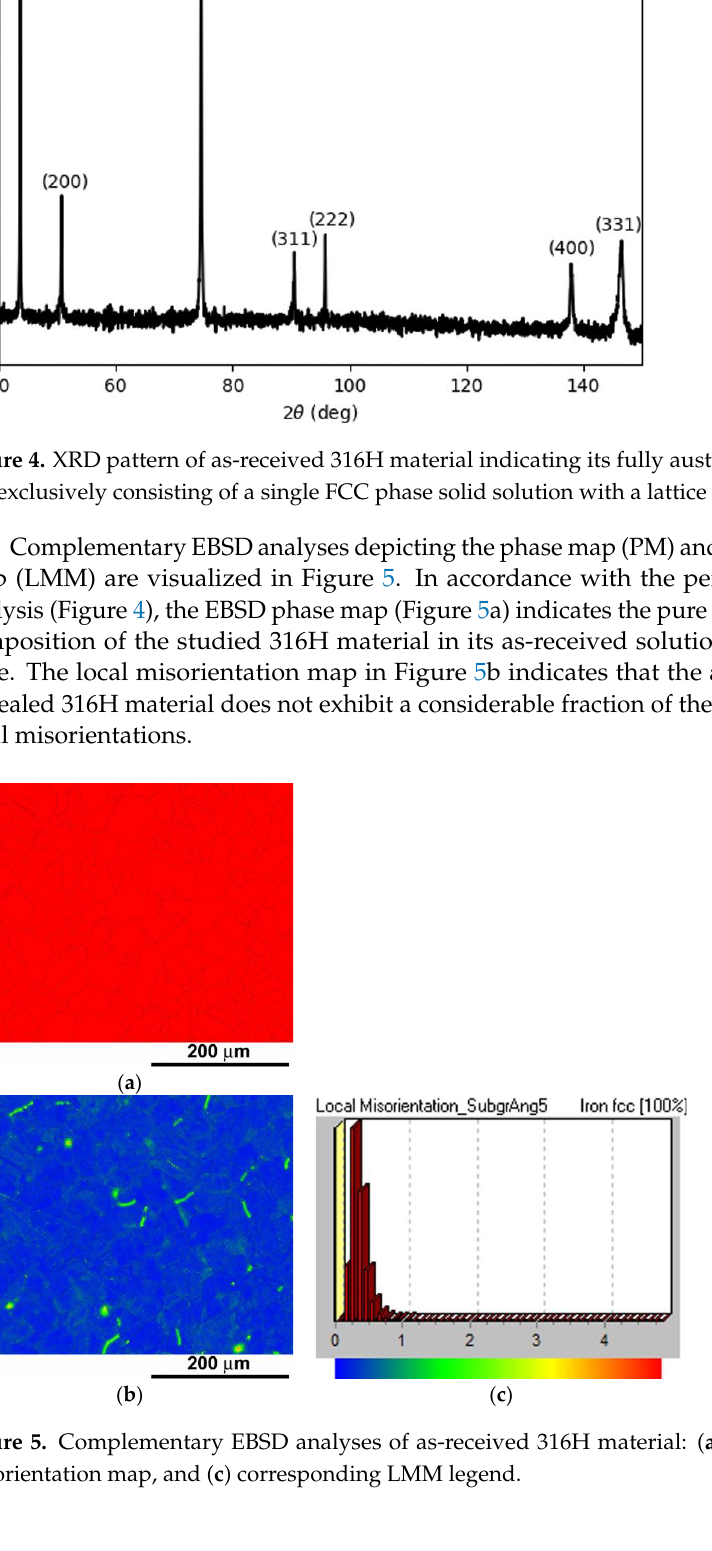
Figure 3. EBSD microstructural analysis of as-received 316H material showing: ( a ) Z-direction in- verse pole figure and ( b ) corresponding IPF color key.